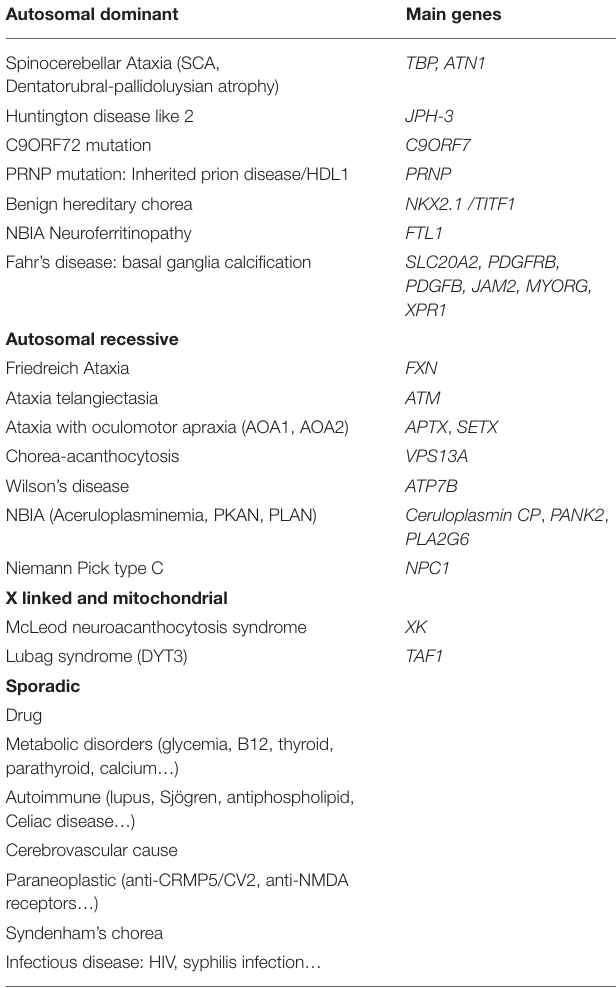
TABLE 1 | Diagnoses found in adults with non-Huntington chorea (2,